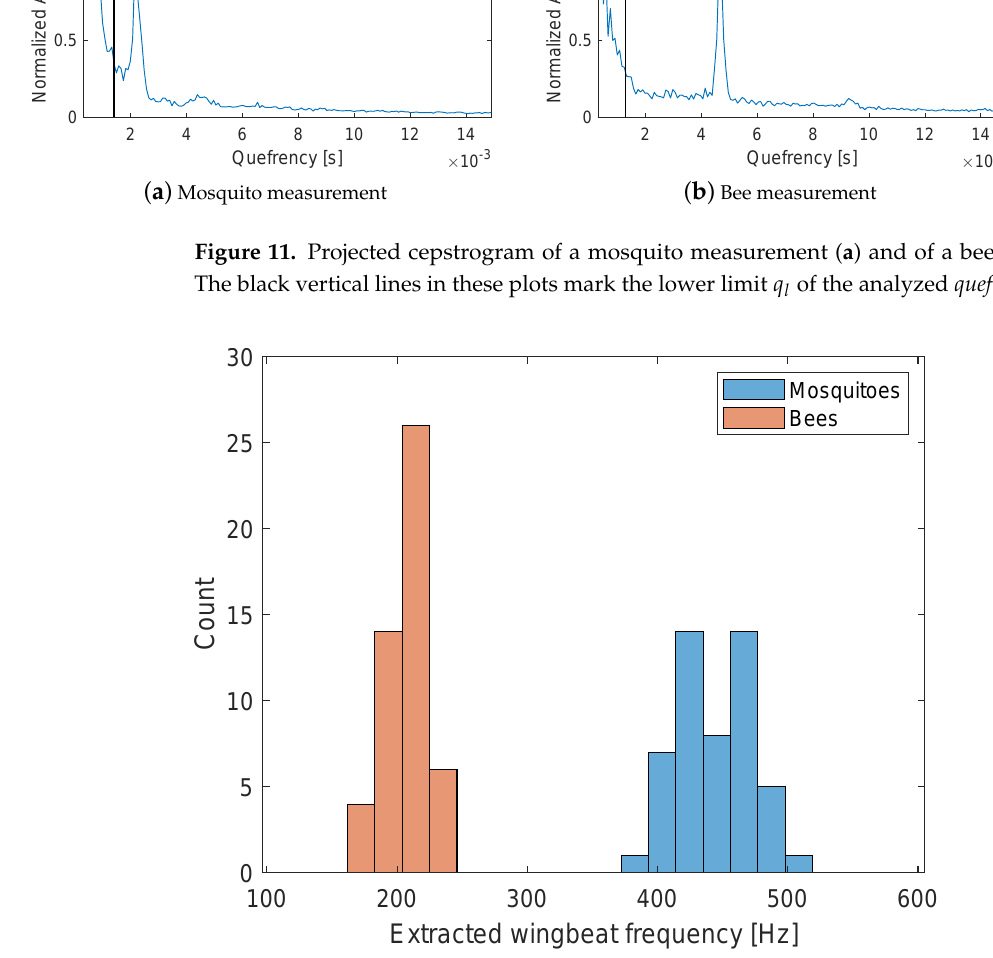
Figure 12. Wingbeat frequencies extracted from mosquito and bee